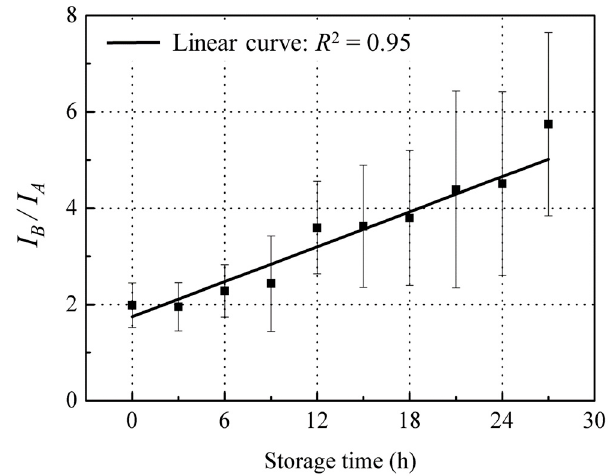
Figure 9. Changes of I B / I A during the storage time. Values shown are the means of 9 replicates with standard deviation bars.